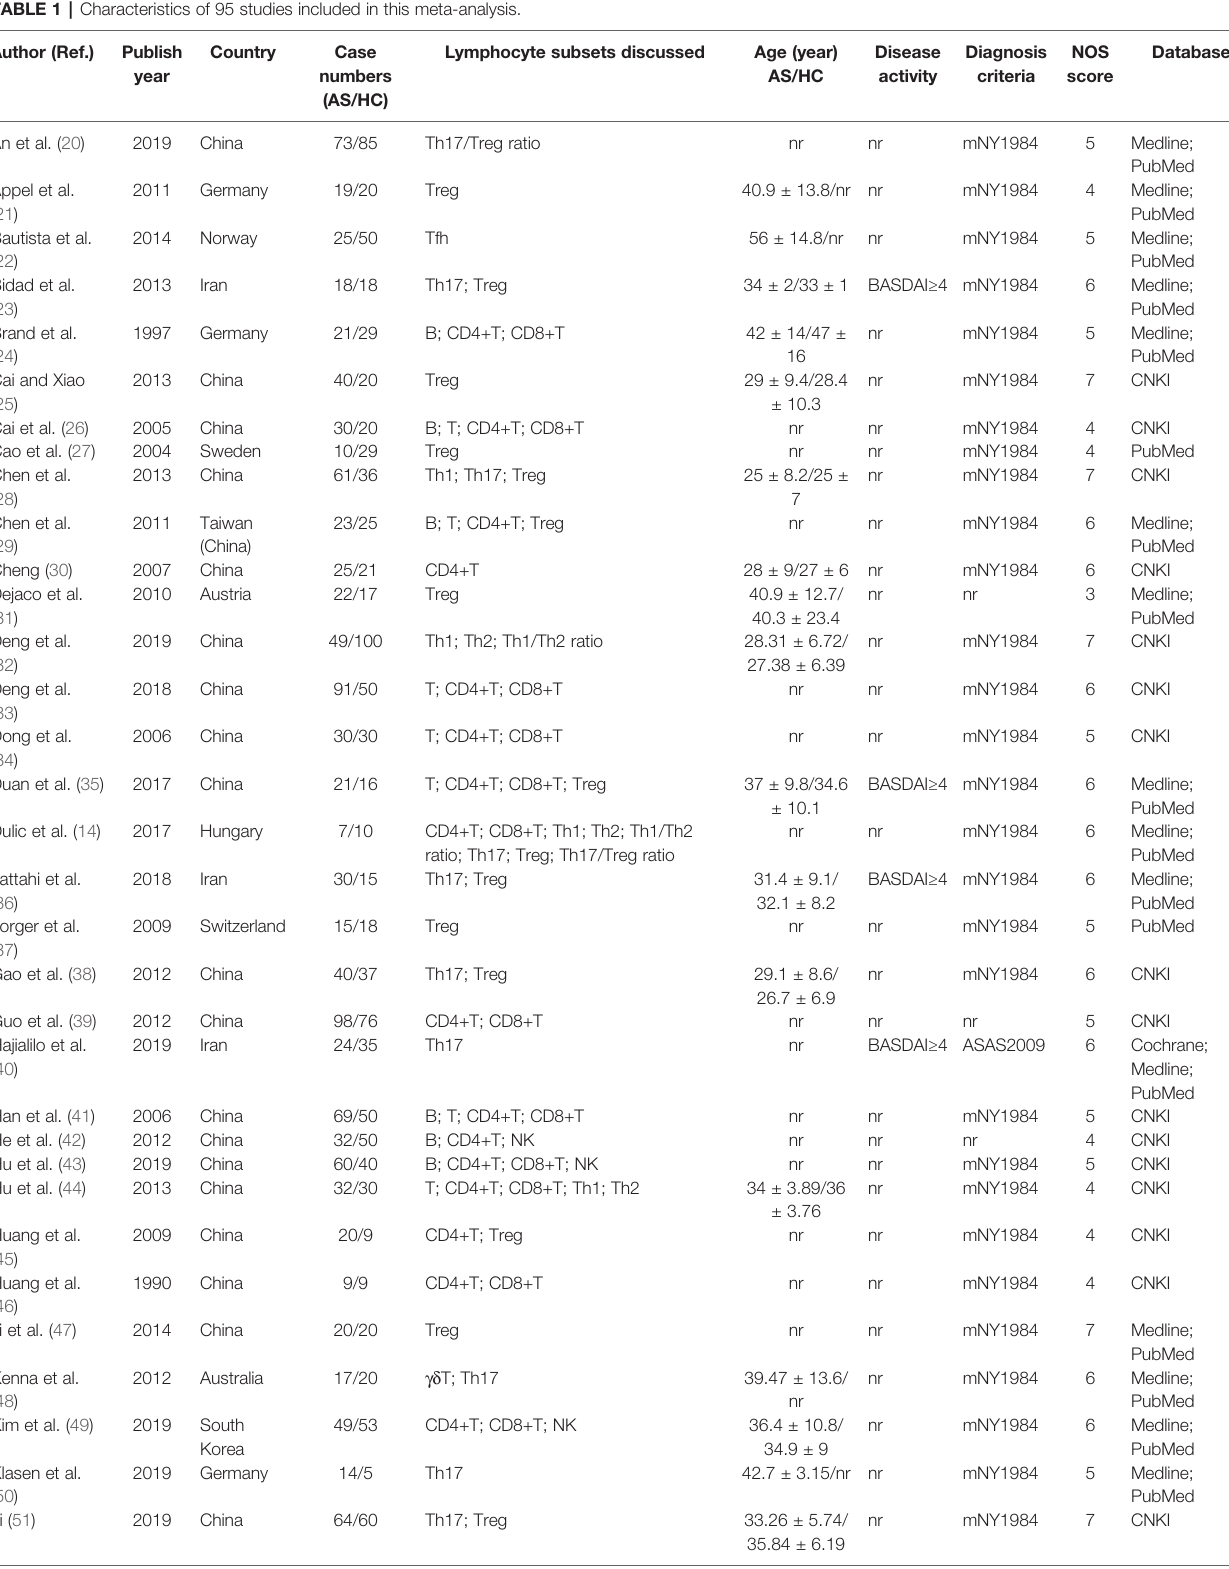
TABLE 1 | Characteristics of 95 studies included in this